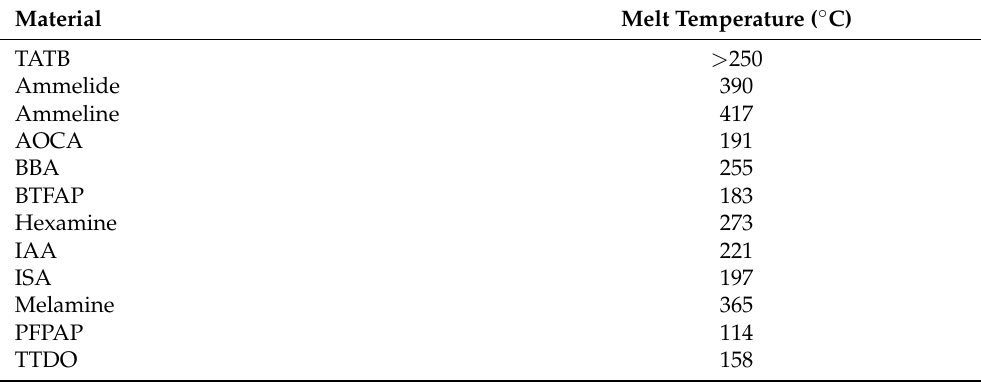
Table 2. Thermal property values of interest for TATB and each material initially under consideration as a thermomechanical TATB